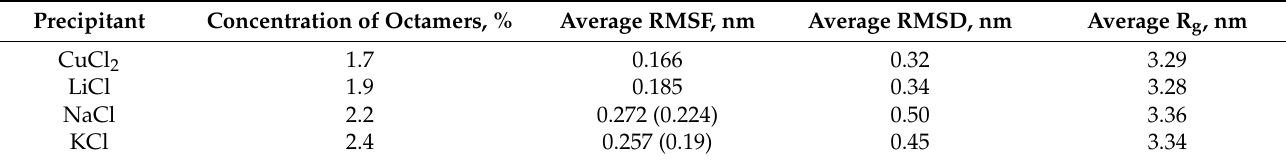
Table 2. Comparison of concentration, RMSF, RMSD and radius of gyration of octamers averaged over 3 simulations and over all C α atoms. Given concentration data are obtained from SAXS measurements [10]. In cases when octamers dissociated into smaller oligomers, there are RMSF values averaged over only two simulations in which the octamers remained as the whole given in brackets.